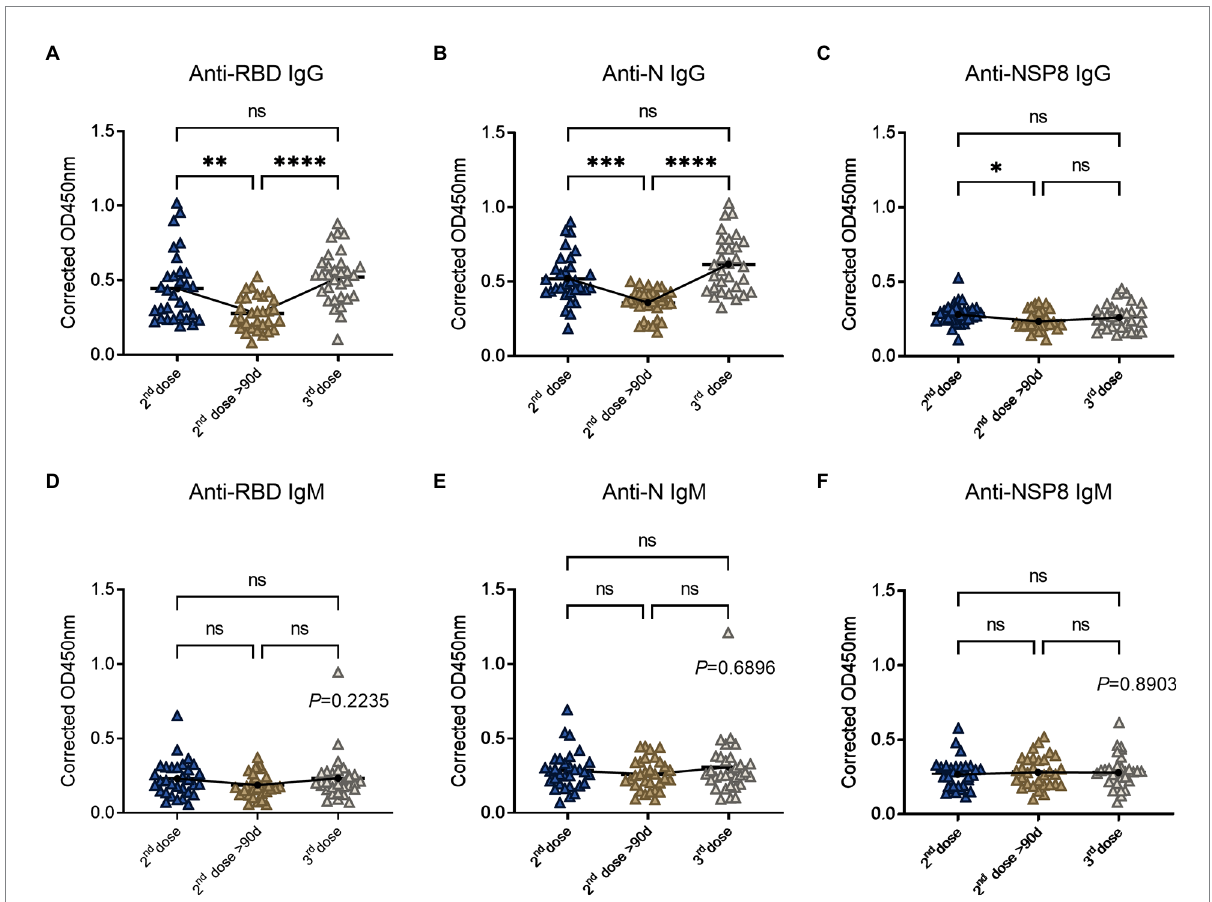
FIGURE 4 SARS-CoV-2 specific antibody responses after the 3 rd dose of vaccination. (A–C) Specific IgG responses to RBD protein (A) , N protein (B) and NSP8 (C) post the 3 rd dose vaccination with two 2 nd dose vaccination subgroups as control. (D–F) Specific IgM responses to RBD protein (D) , N protein (E) , NSP8 (F) post the 3 rd dose vaccination with two 2 nd dose vaccination subgroups as control. Serum samples were from the 10–90 days subgroup ( n = 31), >90 days subgroup ( n = 31) post the 2 nd dose vaccination and the 3 rd dose vaccination group ( n = 31). The p -value was calculated by one-way analysis of variance (ANOVA) or Kolmogorov–Smirnov